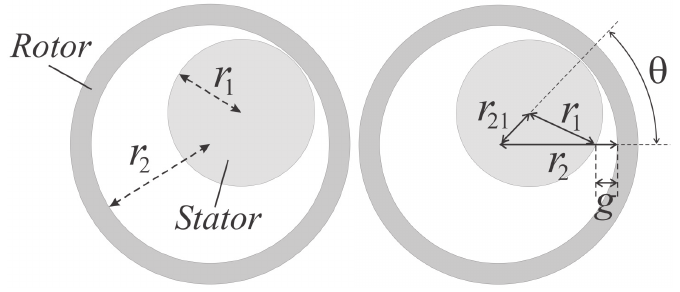
Figure 8. Geometric approach used for airgap